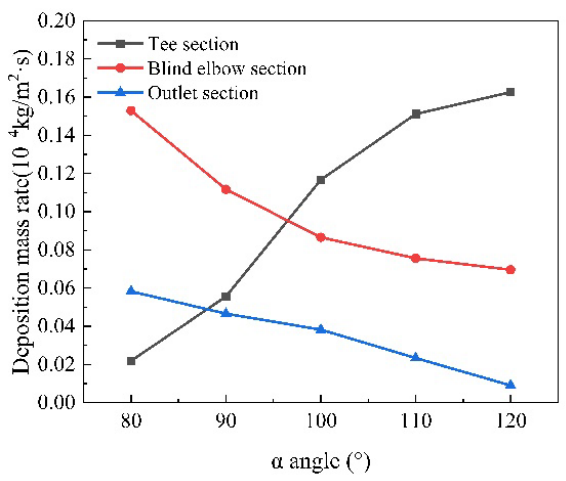
Figure 14. Deposition mass rate of each section for various angle α.